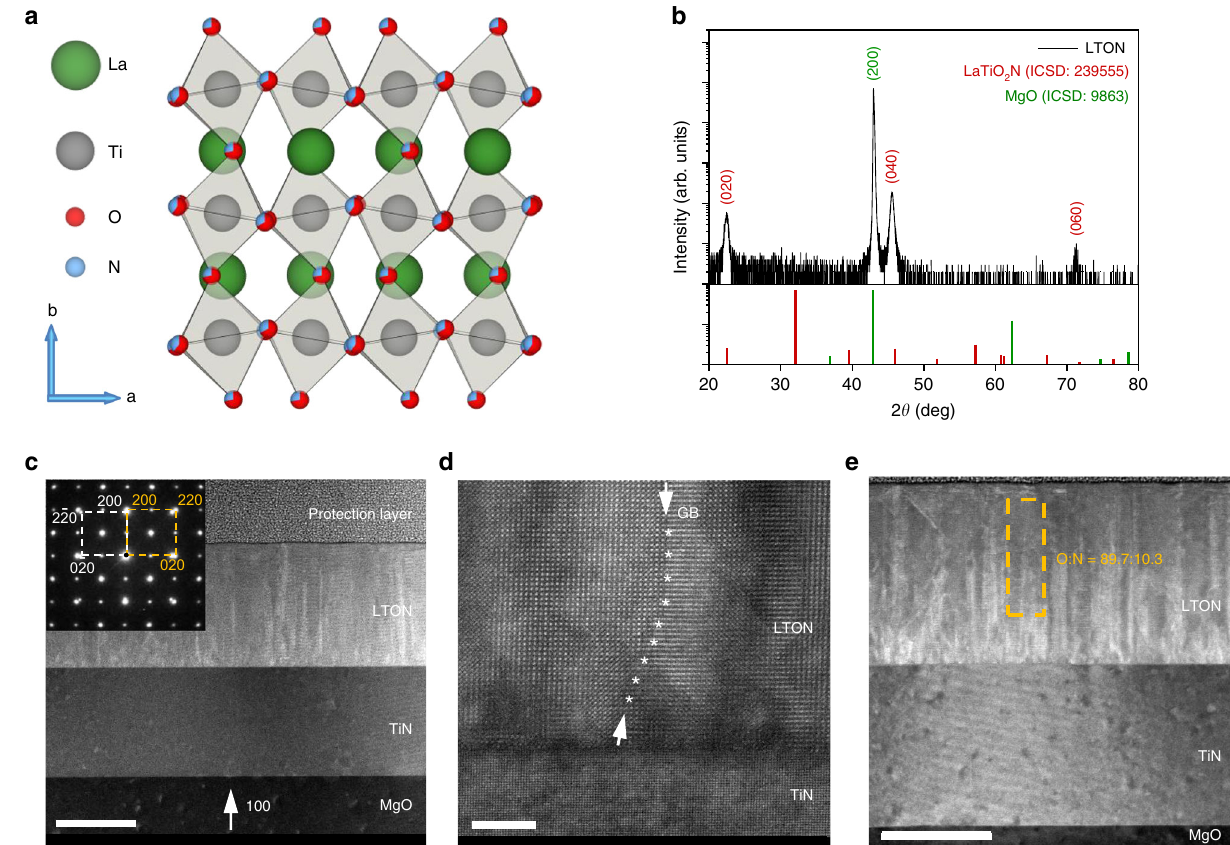
Fig. 1 Structure and morphology characterisation of LTON. a Crystal structure of LaTiO 2 N. b XRD pattern of the epitaxial LTON fi lm, the θ /2 θ is shown in black, with LaTiO 2 N and MgO substrate re fl exes shown below in red and green for reference. Re fl ections are labelled using the (hkl) notation. c TEM cross section of the LTON – TiN fi lm grown on MgO. The scale is 100 nm. d High-angle annular dark- fi eld (HAADF) image; a grain boundary (GB) is tracked with asterisks. The scale is 5 nm. e O:N ratio determined by the TEM/EELS analysis; the scale is 100